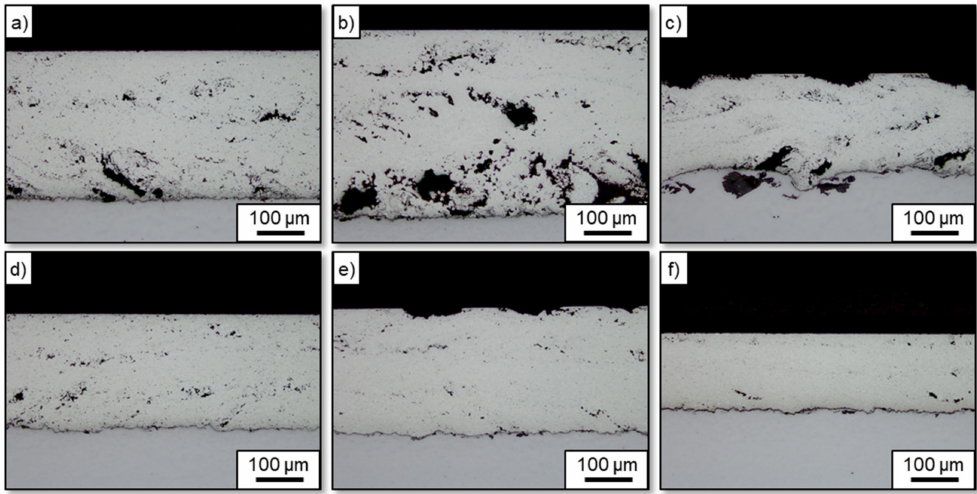
Figure 2. Cross-section images showing the coating microstructure with the use of di ff erent PGT and ST: ( a ) PGT: 300 ◦ C, ST: 20 ◦ C; ( b ) PGT: 350 ◦ C, ST: 20 ◦ C; ( c ) PGT: 400 ◦ C, ST: 20 ◦ C; ( d ) PGT: 300 ◦ C, ST: 260 ◦ C; ( e ) PGT: 350 ◦ C, ST: 260 ◦ C; and ( f ) PGT: 400 ◦ C, ST: 260 ◦